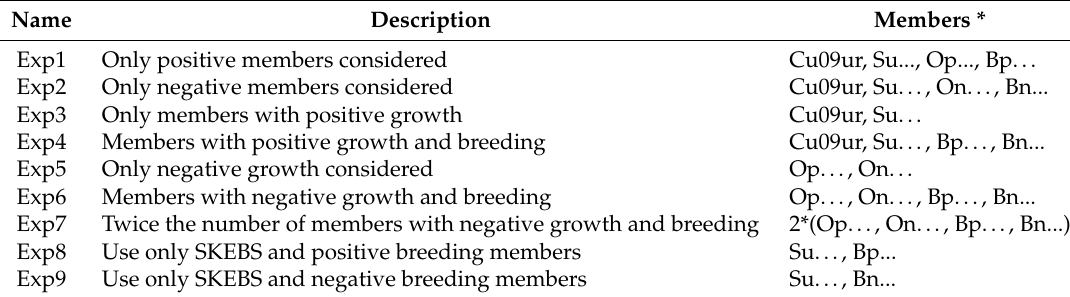
Table 4. Description of the experiments to evaluate the information